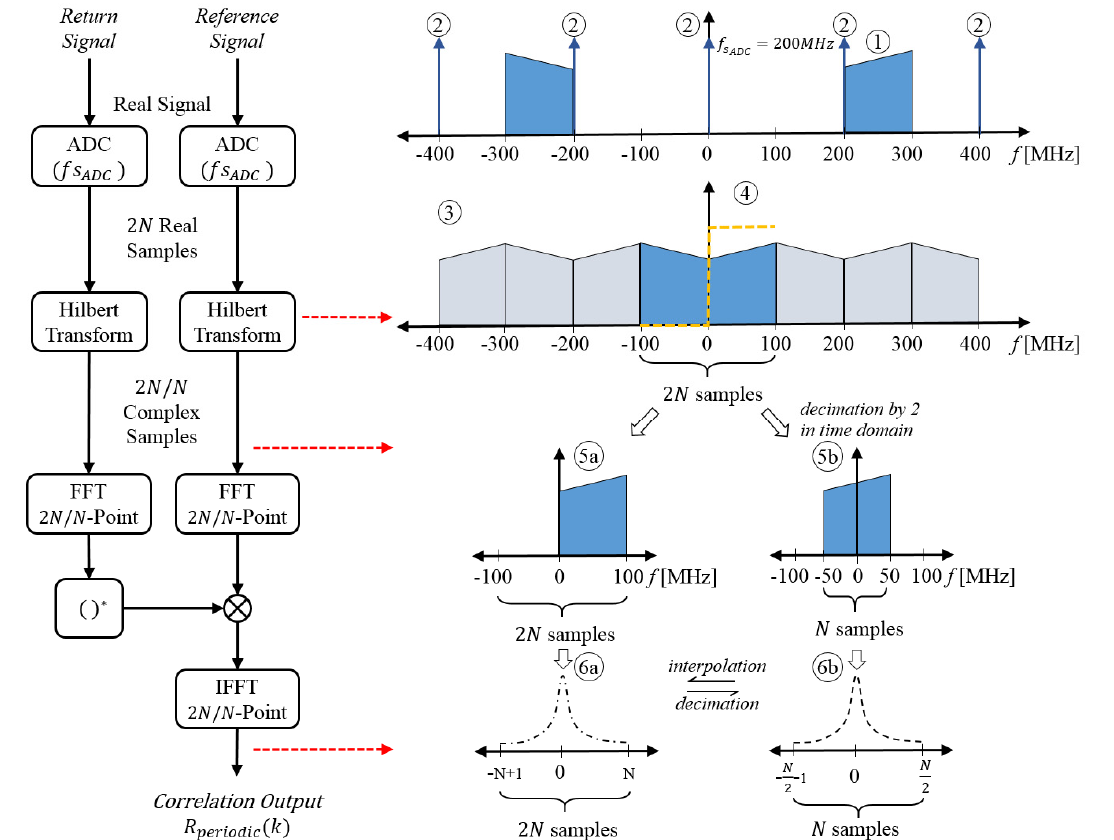
Figure 2. Periodic correlation processing in spectral domain. (1) Spectrum of the “Low IF” signal. (2) Spectrum of the sampling comb (arbitrary units) at fs ADC = 200 MHz. (3) Their convolution and the low frequency alias (2 N samples) of the IF signal. (4) Transfer function of the Hilbert filter. (5a/b) Resulting low-pass component with 2 N significant samples ( N samples for the decimated case, i.e., I and Q components) in both frequency and time. (6a/b) Periodic cross-correlation result with 2𝑁 samples ( 𝑁 samples for the decimated case).